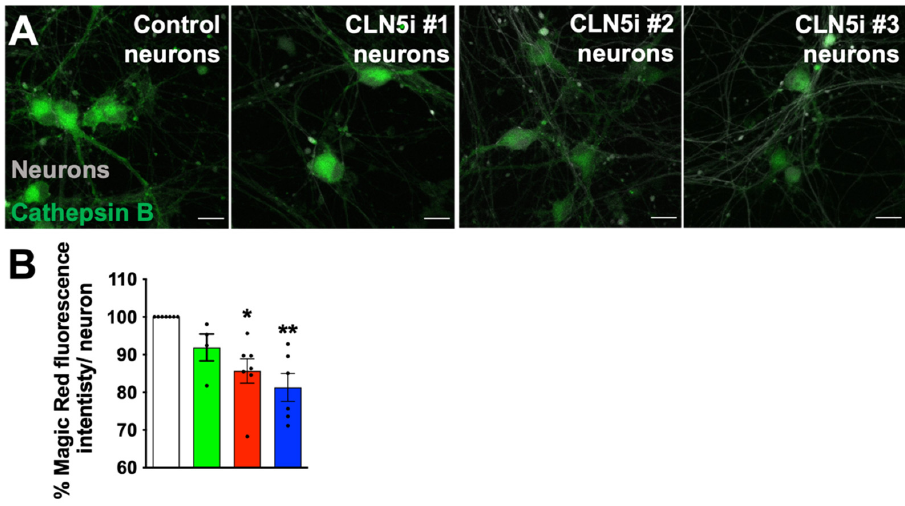
Figure 3. CLN5-deficient human neurons exhibit reduced lysosomal enzyme activity. ( A,B ) Microscopic analysis of lysosomal cathepsin B activity in the iPSC-derived human neurons revealed reduced enzyme activity (measured by Magic Red assay—compare pseudo-colour green dots) in CLN5-deficient neurons (#2 and #3) compared to control neurons. n ≥ 3, * p < 0.05, ** p < 0.01. Scale bar = 20 µm.